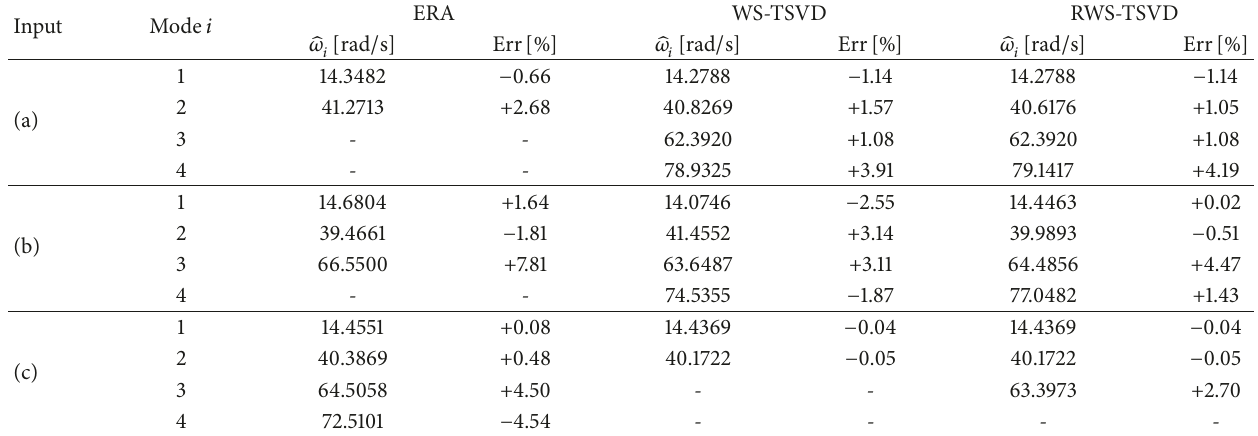
Table 4: Modal parameters identified by ERA, WS-TSVD-based algorithm, and RWS-TSVD-based algorithm on the undamaged frame, with reference to input accelerations of Figure 8.